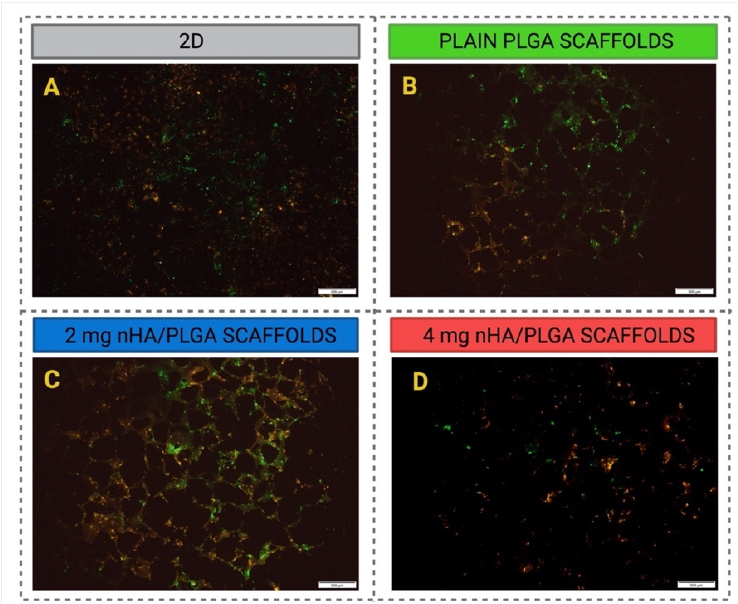
Figure 7. Representative co-culture images of cell distribution in 2D and 3D. hFOB 1.19 stained green and PC-3 stained red. ( A ) 2D co-culture. Scale bar 200 μ m, ( B ) PLGA 3D scaffolds, ( C ) 2 mg nHA/PLGA scaffolds; and ( D ) 4 mg nHA/PLGA scaffolds. Scale bar: 500 μ m.